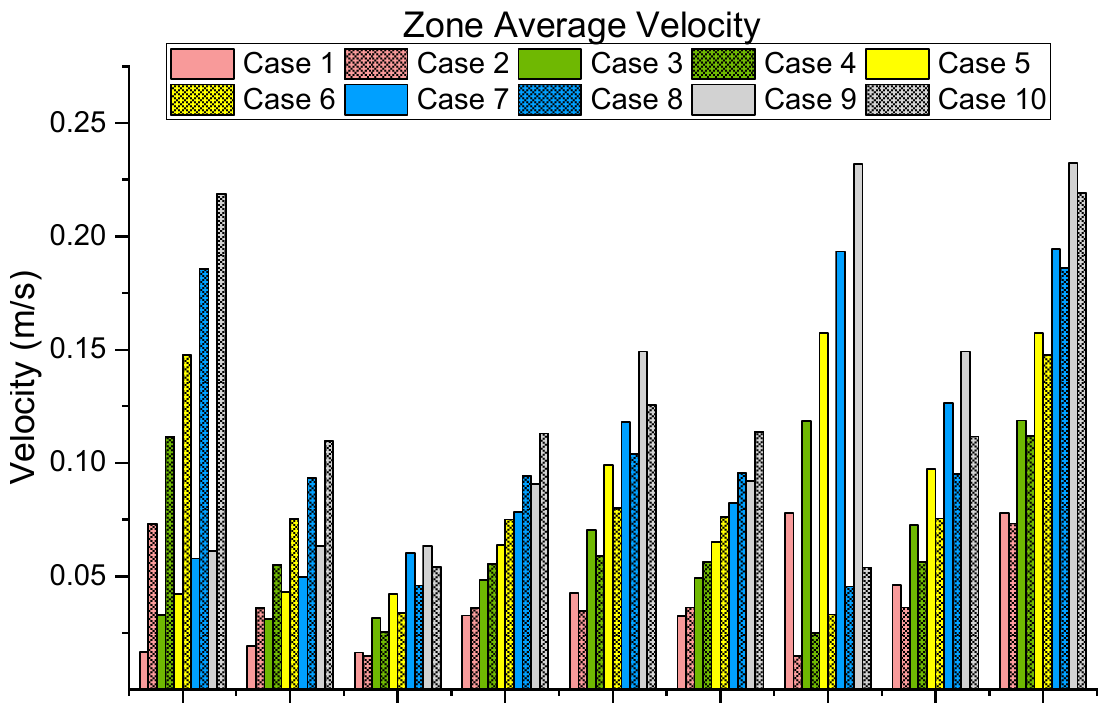
Case 5 vs. Case 6, for the zones closest to the inlets, the velocity is slightly lower for the opposite-side configurations. When comparing the zones that are farthest from the inlets, Zones 1 and 3 for Case 7 and Zones 3 and 7 for Case 8, the results show that Zones 3 and 7 for Case 8 have a slightly lower average velocity at 0.06 vs. 0.05 m/s. When comparing Case 7 vs. Case 8 in Zone 5, the results show a slightly lower average velocity for Case 8 at 0.12 vs. 0.10 m/s. Overall, Case 8 had a lower average velocity in five zones, Zones 3, 5, 7, 8, and 9, compared to Case 7. When evaluating the maximum velocity, the results show that, for Case 7, Zones 7 and 9 show the highest velocity at 0.26 m/s, and for Case 8, it is 0.25 m/s Zones 1 and 9.